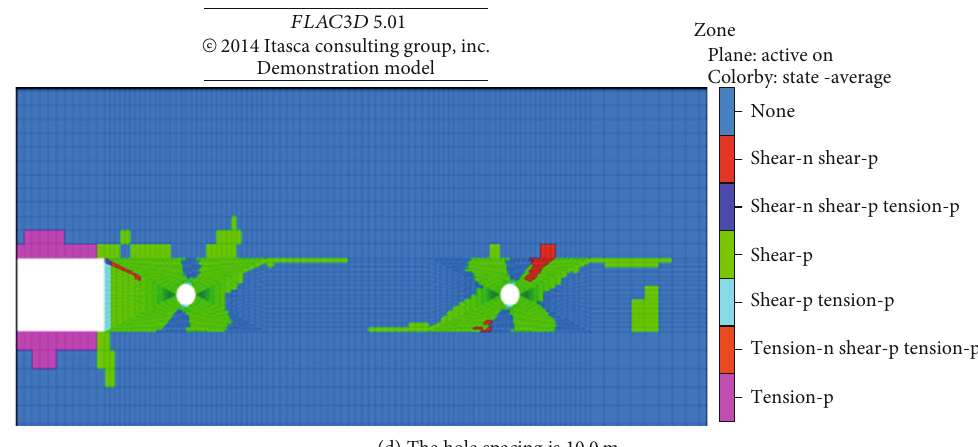
Figure 16: Plastic zone distribution under di ff erent hole